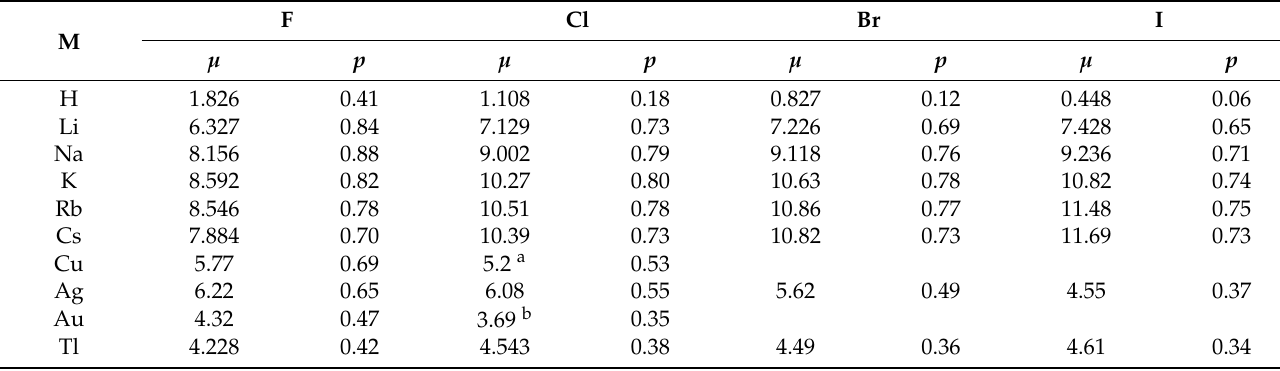
Table 7. Dipole moments (in D ) and bond polarities in MX